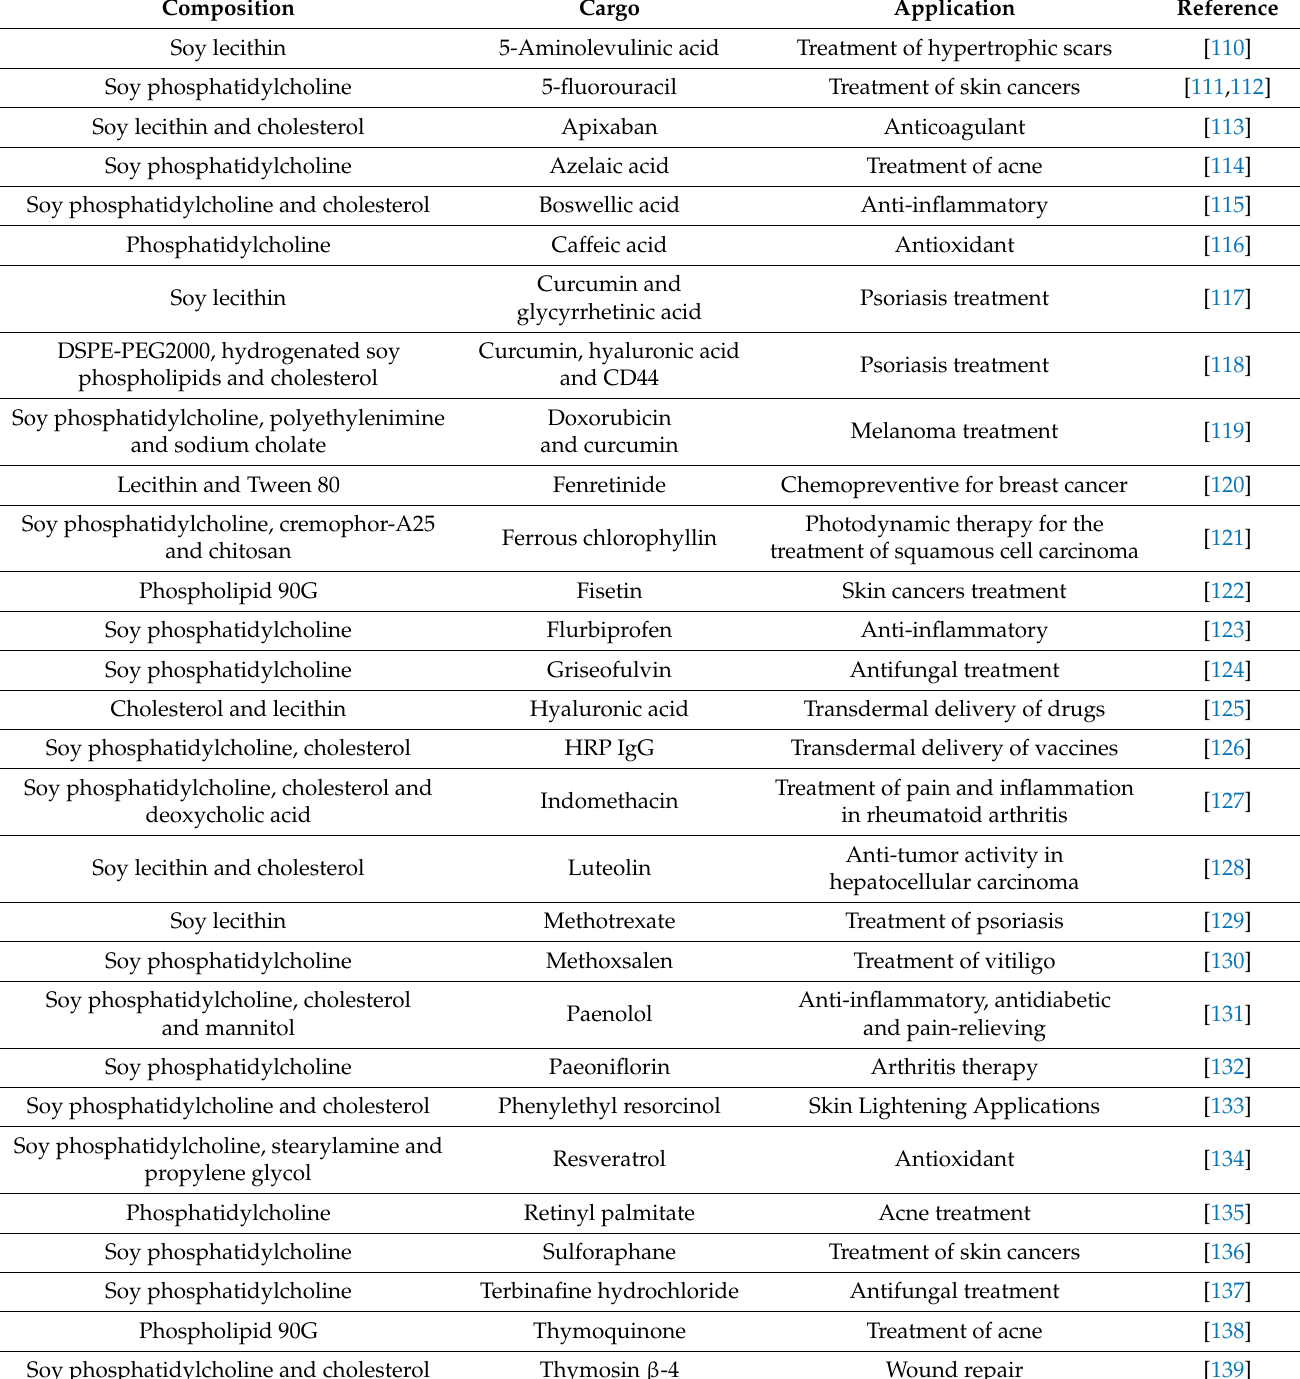
Table 3. Ethosomes’ drug delivery